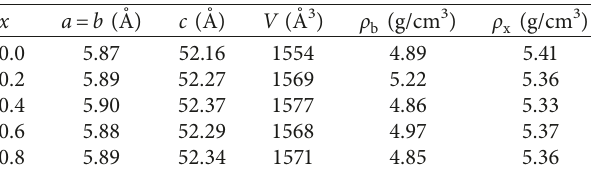
Figure 1: XRD patterns of Ba 3 [Cu 0.8 − x Zn x Mn 0.2 ] 2 Fe 24 O 41 samples: the peaks corresponding to Z-type, M-type, and Y-type hexaferrite are labeled by (Z) M and (Y), respectively. Table 1: The lattice parameters ( a and c ), cell volume ( V ), bulk ), and X-ray density ( ρ ) for the Ba 3 [Cu 0.8- x Zn x density ( ρ b x Mn 0.2 ] 2 Fe 24 O 41